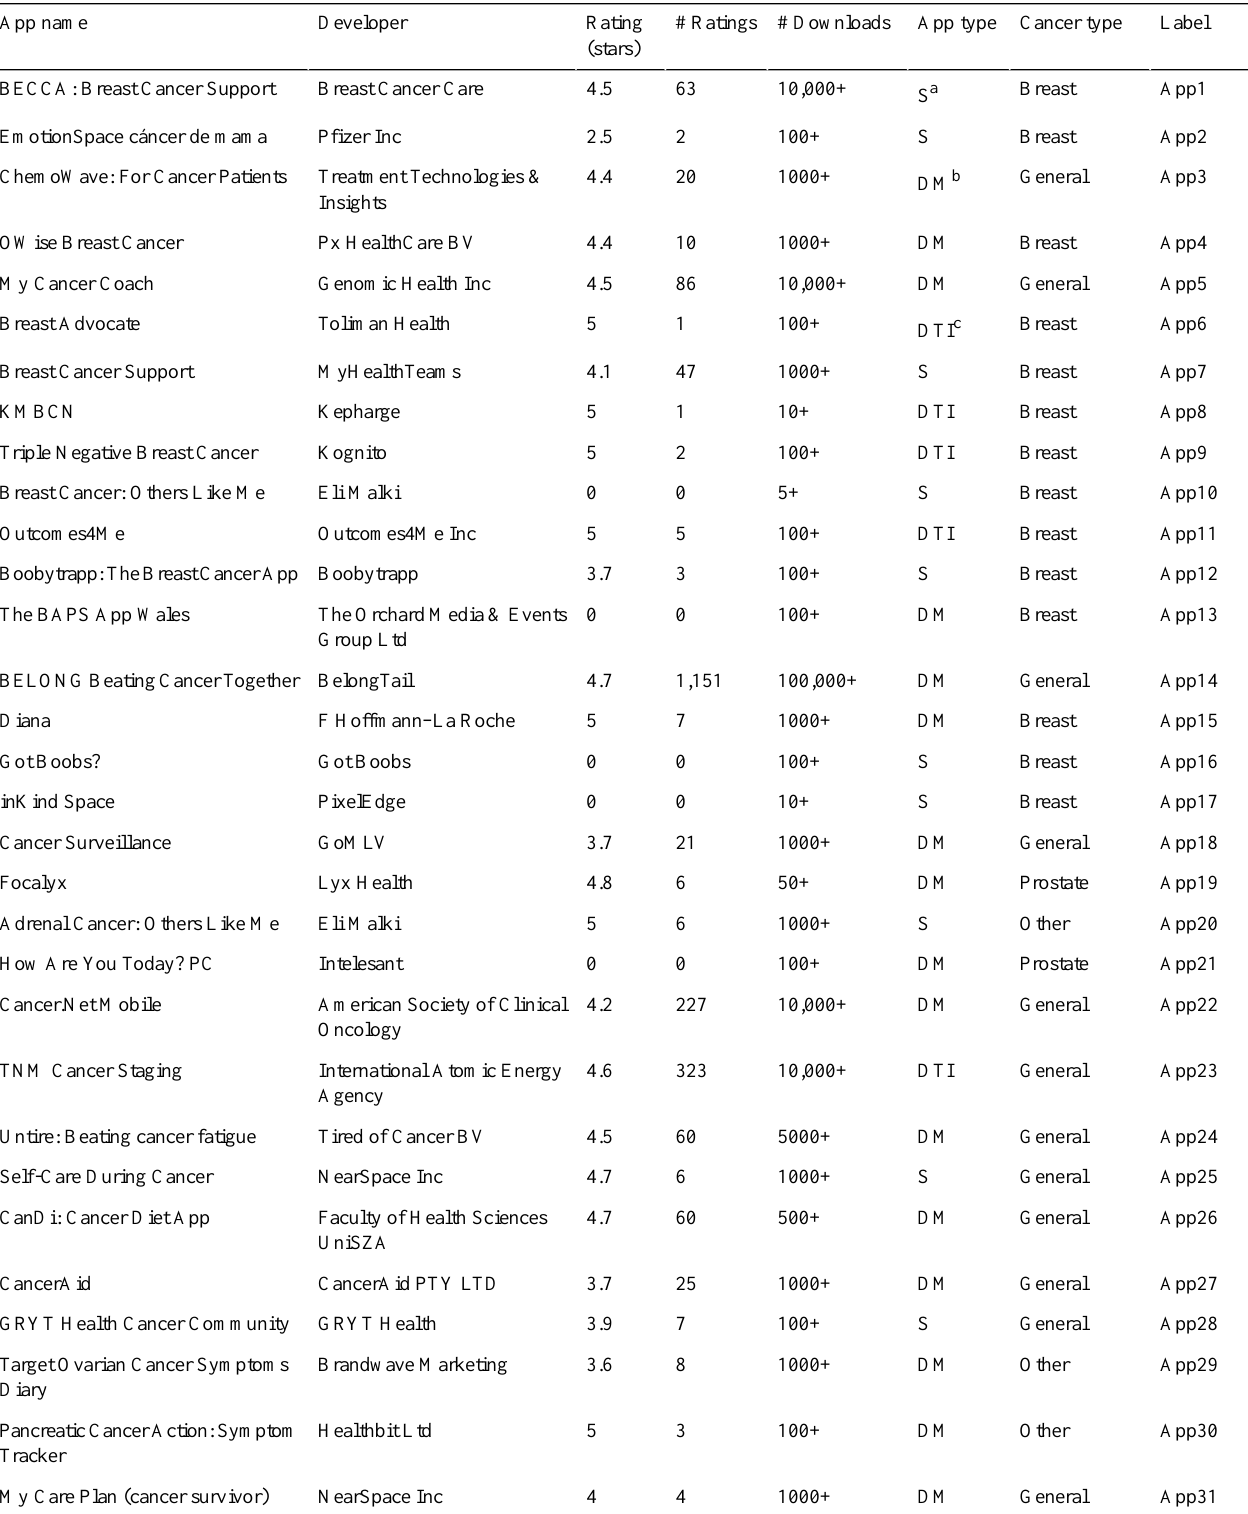
Table 4. Selected